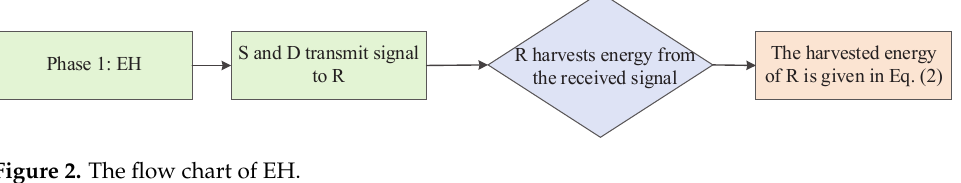
Figure 2. The flow chart of EH.